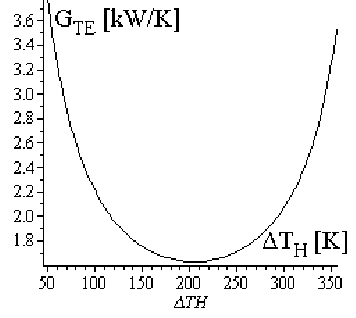
Figure 18. G TE dependence of Δ T H —case “c”. G TEmin = 1.628 for Δ T H = 204.75 K.